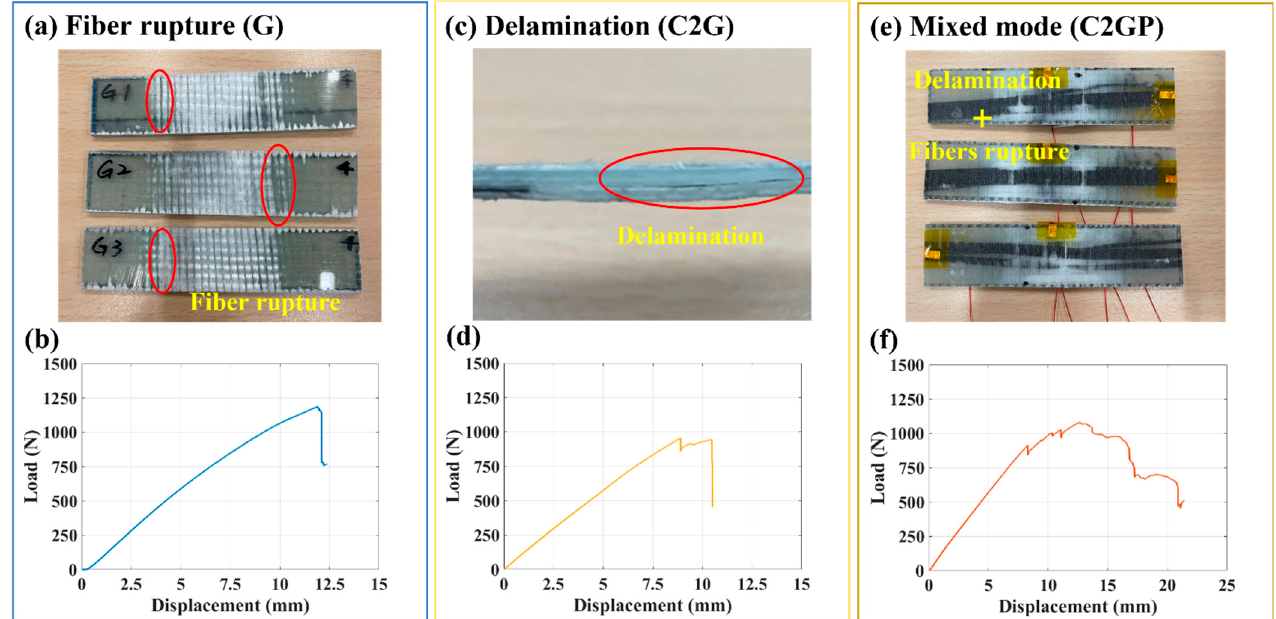
Figure 6. Photographs of specimens under di ff erent damage processes: ( a ) fi ber rupture (G); ( b ) Load–displacement curves for ( a ); ( c )delamination (C2G); ( d ) Load–displacement curves for ( c ); and ( e ) Mixed mode (C2GP); ( f ) Load–displacement curves for ( e ).